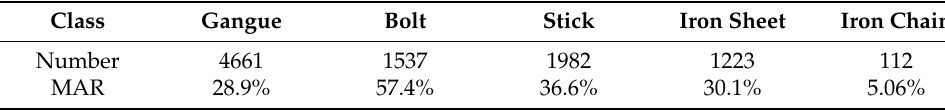
Table 2. Number and MAR of each class.